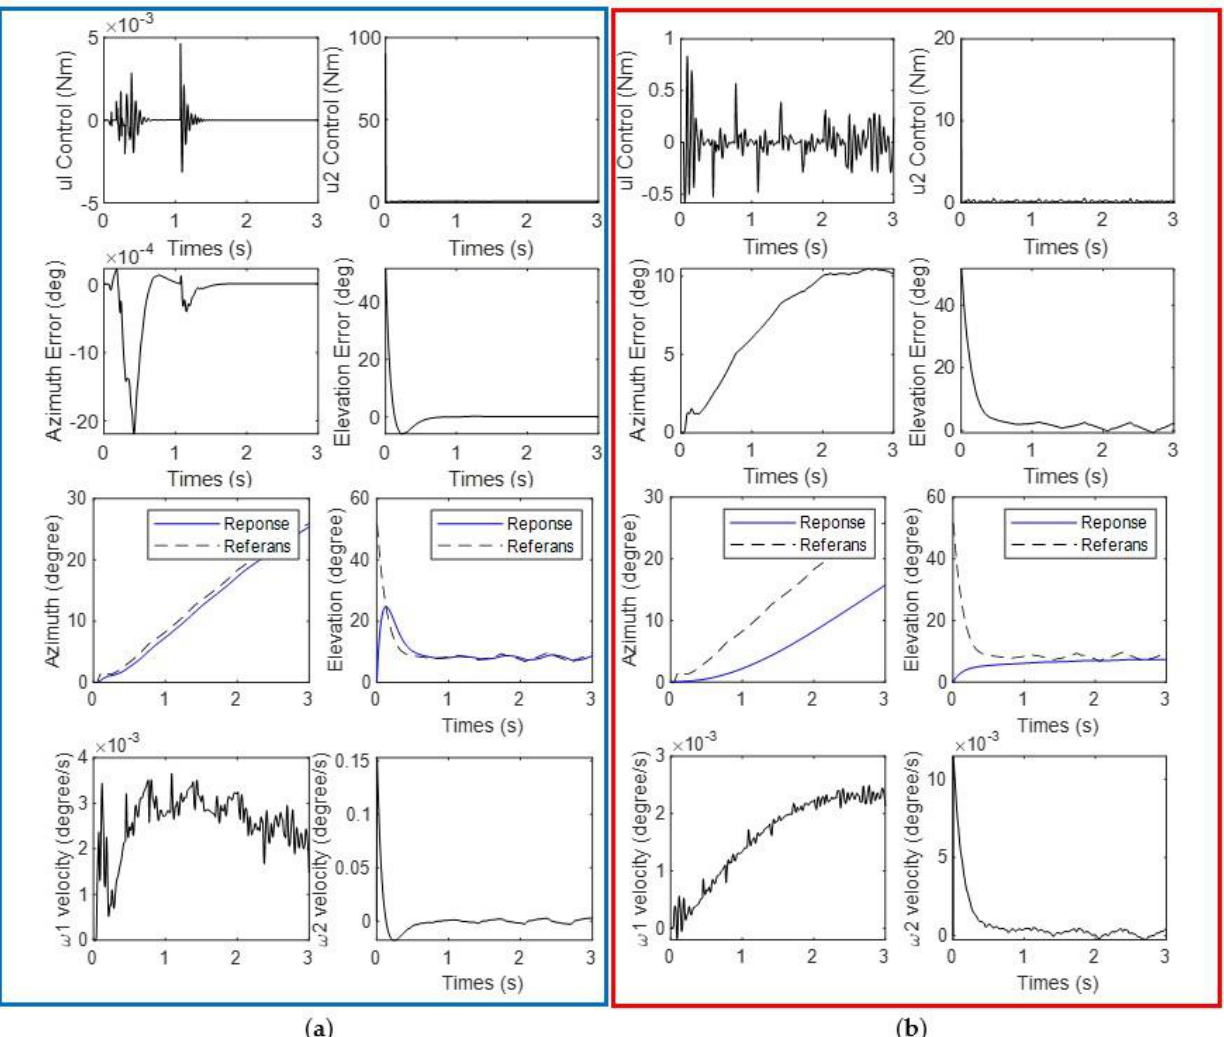
Figure 18. Control signals, error values, trajectory and velocity of Turret System elevation and azimuth motor with ( a ) SMC ( b ) PID controllers for Scenario 3.